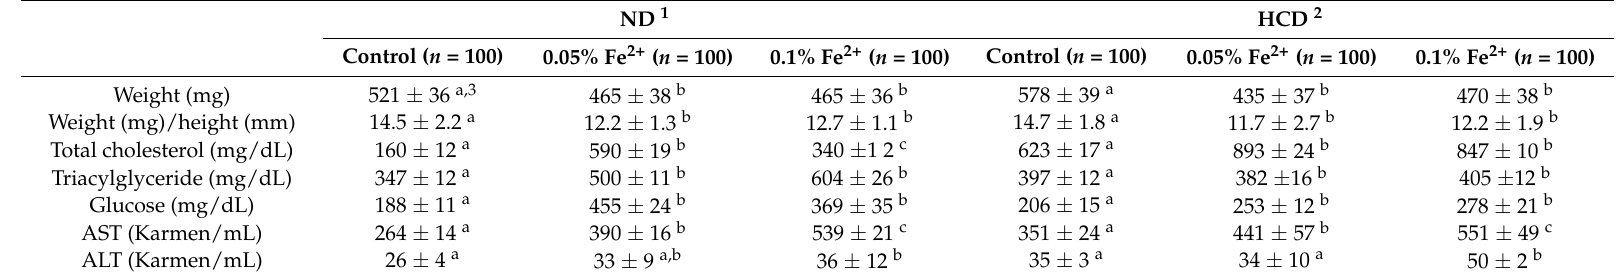
Table 1. Serum parameters of zebrafish after 24 weeks of feeding with FeSO 4 based on normal diet (ND) and high cholesterol diet